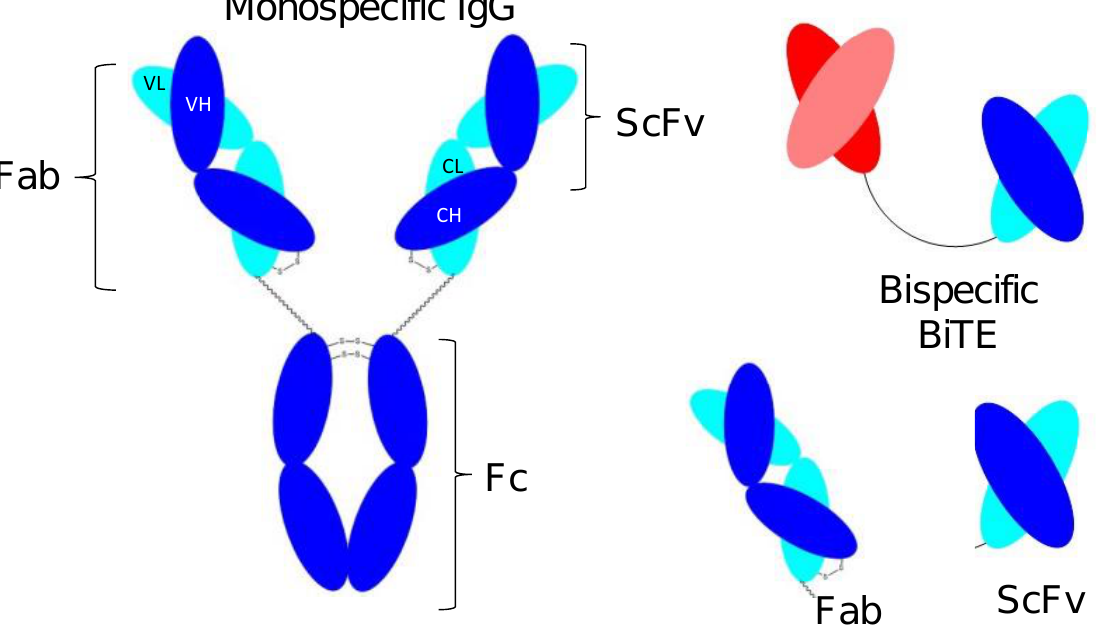
Figure 1. Structure of monospecific IgG, Fab, scFv and BiTE. V H : Variable Heavy Chain, V L : Variable Light Chain, C H : Constant Heavy Chain, C L : Constant Light Chain.